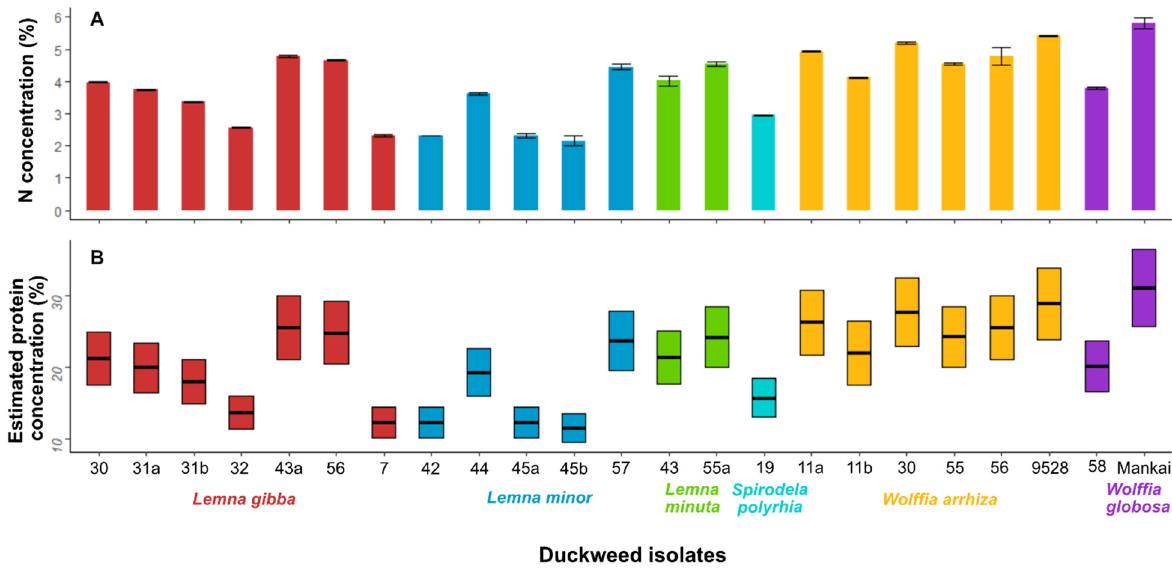
Figure 3. Nitrogen concentration ( A ) and estimated protein concentration ( B ) adjusted to duckweed dry biomass, which is calculated by multiplying nitrogen concentration by 4.4–6.25. The strain W. arrhiza 9528 was added to the analysis as a reference.